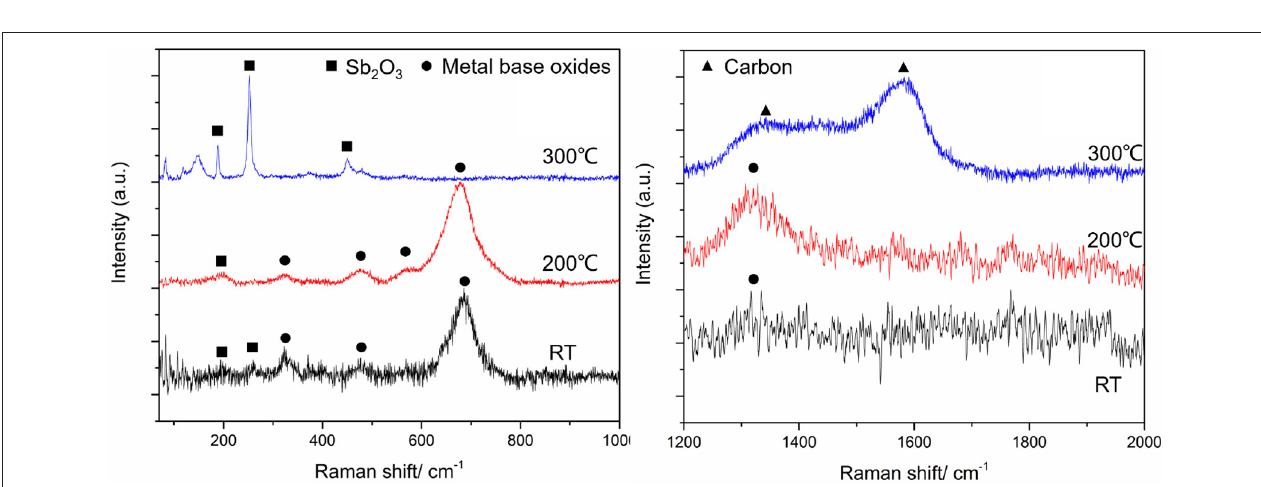
FIGURE 9 | Raman results of the worn Sb 2 O 3 -MSH/C surfaces under different temperature conditions.